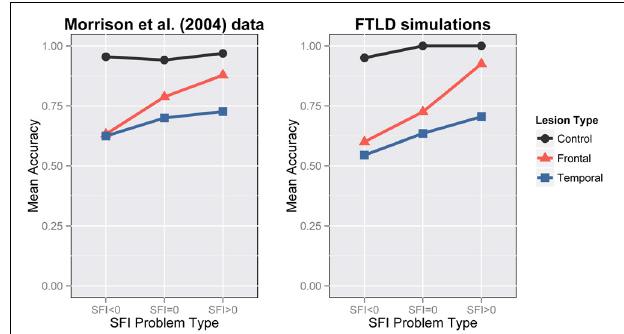
FIGURE 6 | Frontotemporal lobar degeneration simulations. Performance on analogy problems per problem-type for various lesions. Left : FTLD data from Morrison et al., 2004 (Reprinted with author’s permission). Right : Simulation 2